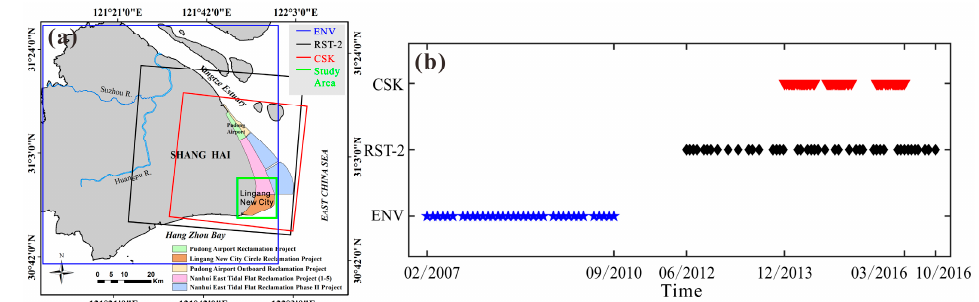
Figure 1. ( a ) Location of the Lingang New City of Shanghai, the coverages of the ENVISAT ASAR (ENV), Radarsat-2 (RST-2), and COSMO-SkyMed (CSK) synthetic aperture radar (SAR) datasets are depicted by the green, blue, black, and red rectangles, respectively. ( b ) Temporal distribution of the ENV, RST-2, and CSK datasets.